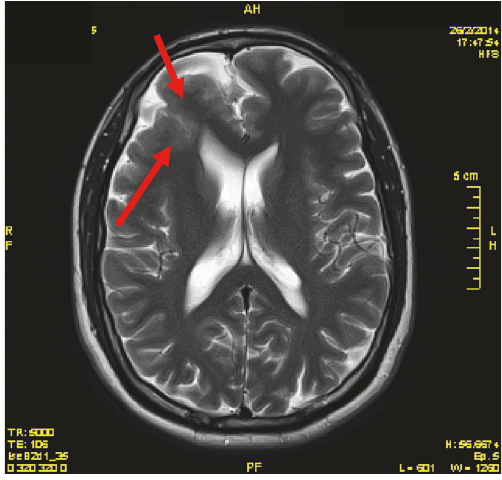
Figure 2: MRI-T2